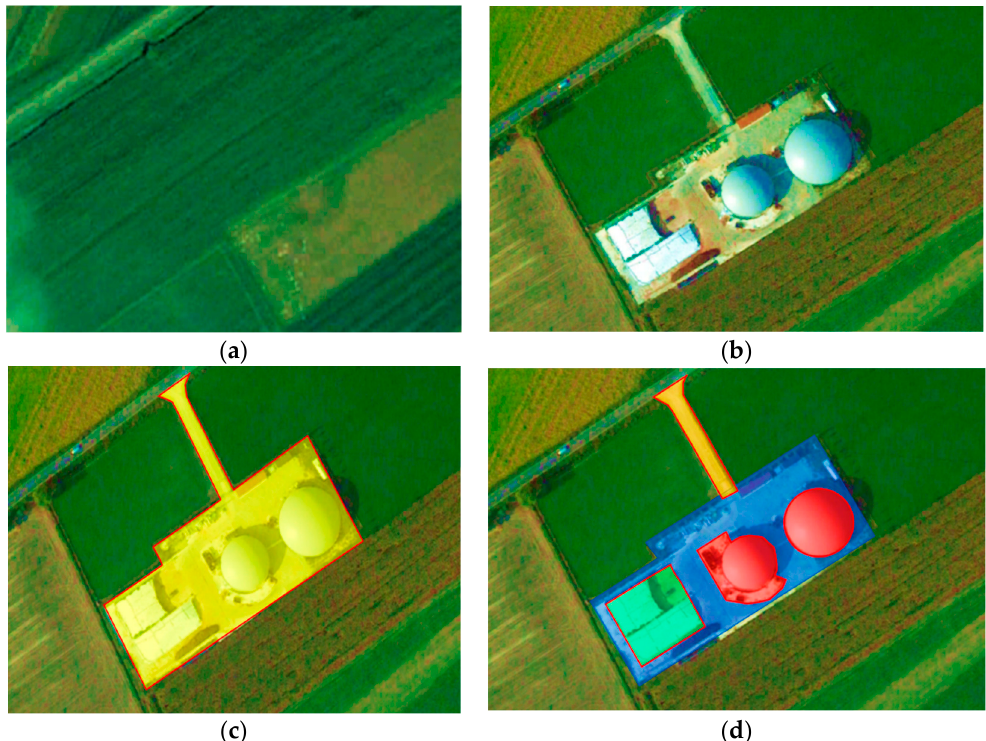
Figure 3. Before ( a ) and after ( b ) situation of a soil surface converted from agricultural cultivation land into a plant for anaerobic digestion with the scheme of the built structures. The total area occupied by the plant ( c ); the land surface occupied by digester structures (red), storage surfaces (green), new roads (orange), and other structures and remaining areas (blue) ( d ).